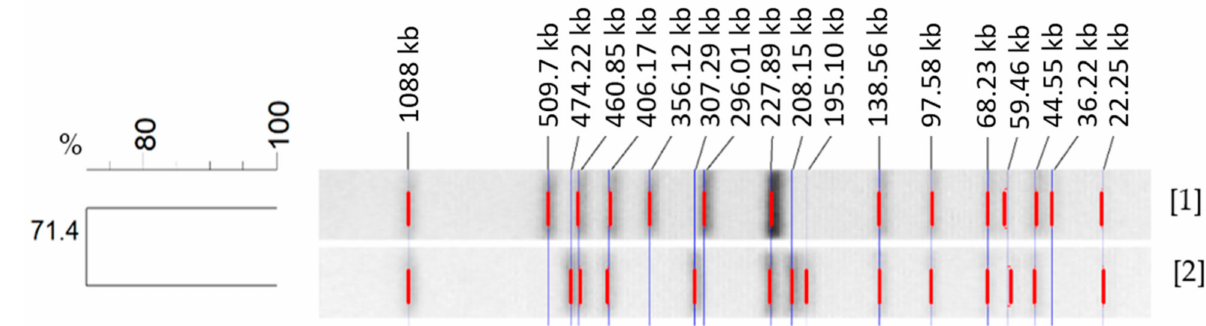
Figure 3. Genetic relatedness of S. Choleraesuis strains of plant [1] and animal origin [2] determined by PFGE with restriction enzyme Xba I, showing conserved and disparity bands. Cluster analysis of the resulting band pattern was performed using the Dice coefficient and UPGMA with band tolerance 0.8%.